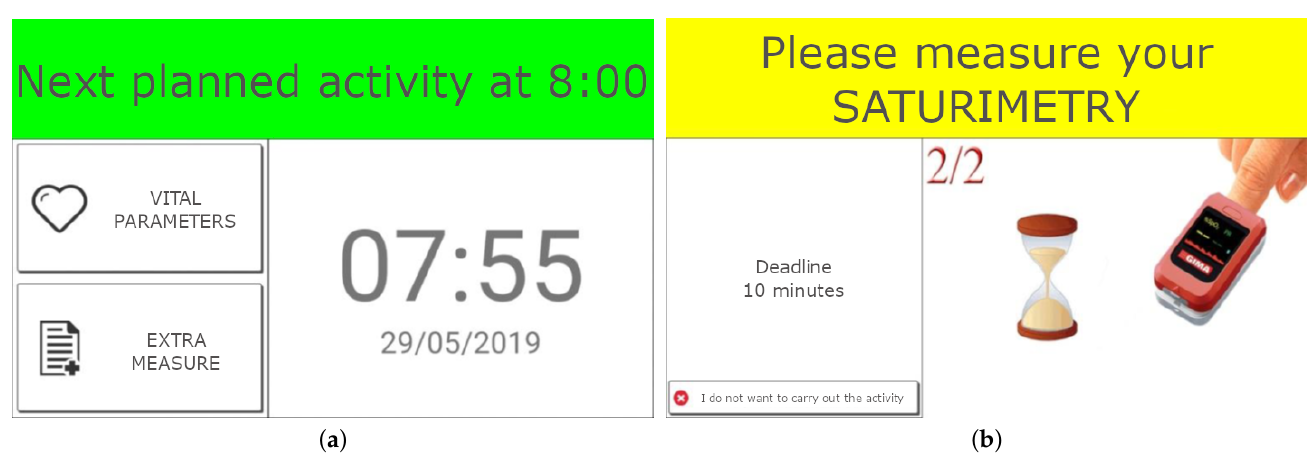
Figure 7. GUI of E@syCare software application: ( a ) main screen; ( b ) measurement request